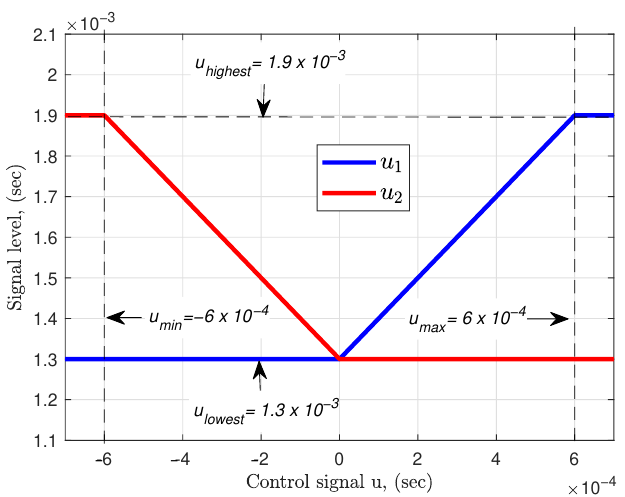
Figure 4. Distribution of the input signal u ( t ) between the two